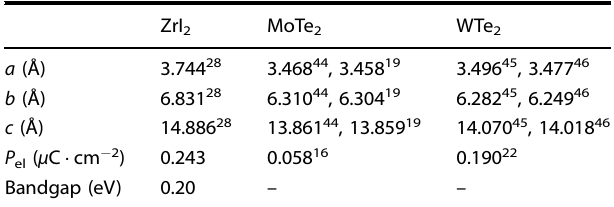
Fig. 1. The effect of spin-orbit coupling was shown to give minor changes (see Supplementary Fig. 4a).